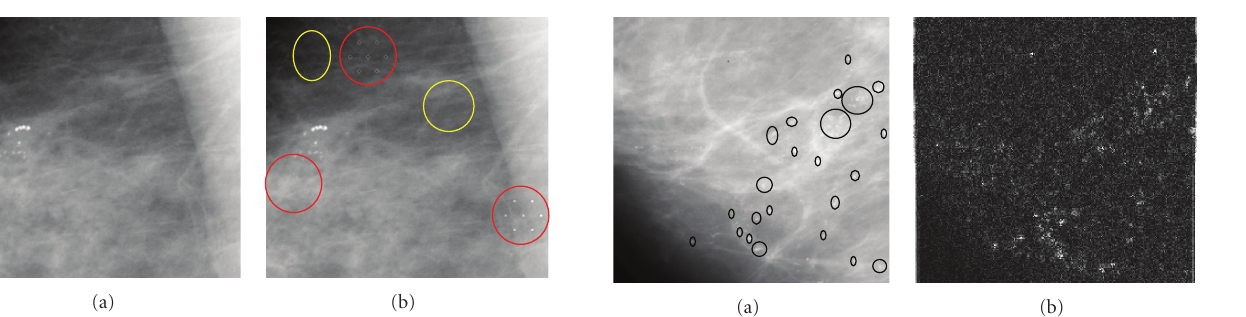
Figure 6: Highpass filtering using wavelet transform: (a) original mammogram region with MCs marked, (b) enhanced MCs (bright locations) obtained using 2-level DWT filtering